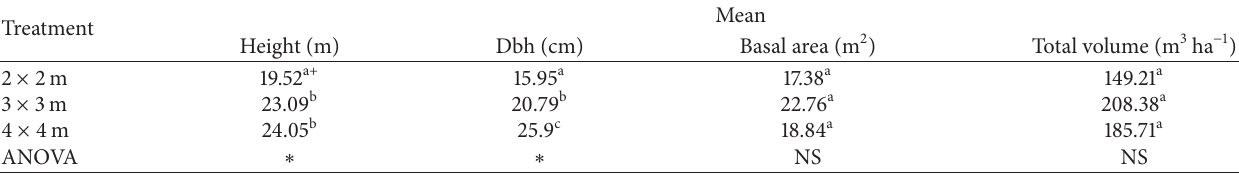
Table 1: Effect of spacing on growth and yield of T. grandis at LFP.